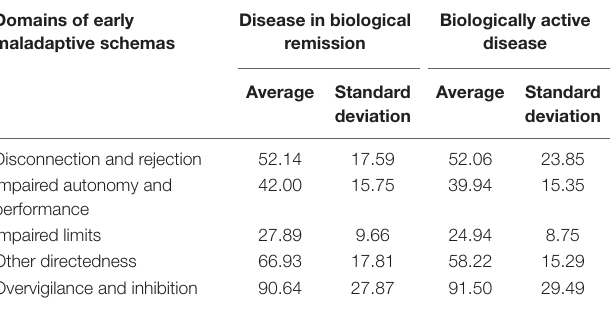
TABLE 1 | Distribution of scores by domain according to disease